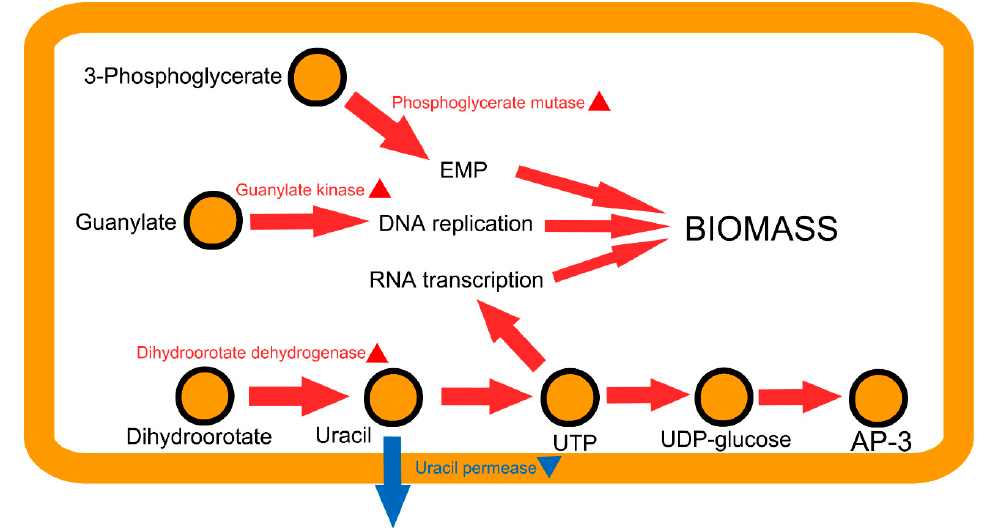
Figure 9. The mechanism of the optimized modification strategy to improve AP-3 and growth. The arrows represent flux rate of particular biological processes related with the biomass and AP-3 biosynthesis. The modification sites identified by OptRAM are labeled with triangle, and the red and blue ones mean overexpression or underexpression, respectively. Red and blue colored arrows represent up- or downregulation of the reactions in modified strain compared to the wild-type. AP-3: ansamitocin P-3; EMP: Embden Meyerhof Parnas pathway; UTP: uridine triphosphate; UDP: uridine diphosphate.